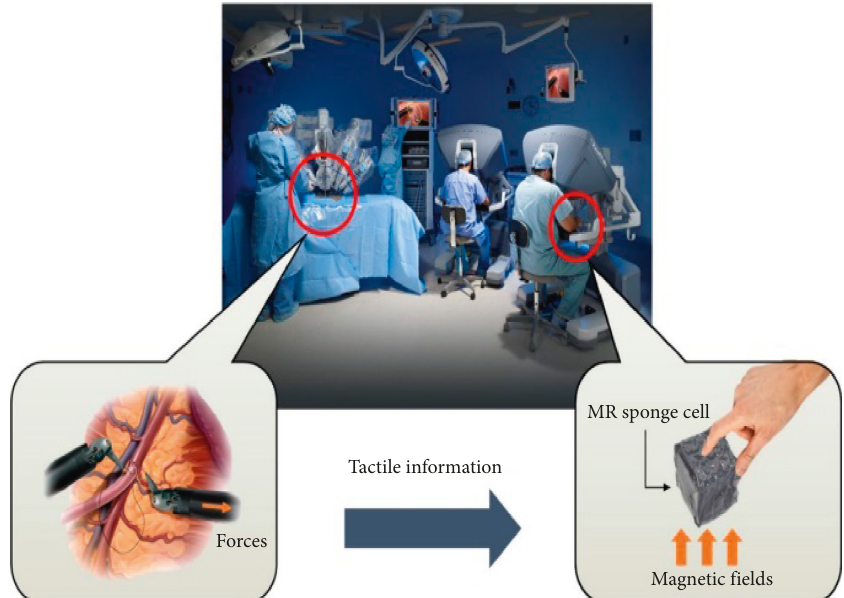
Figure 12: Schematic illustration of RMIS using MR sponge cell as a tactile sensor (adapted with permission from Ref. [111]; copyright 2016, Elsevier publishing